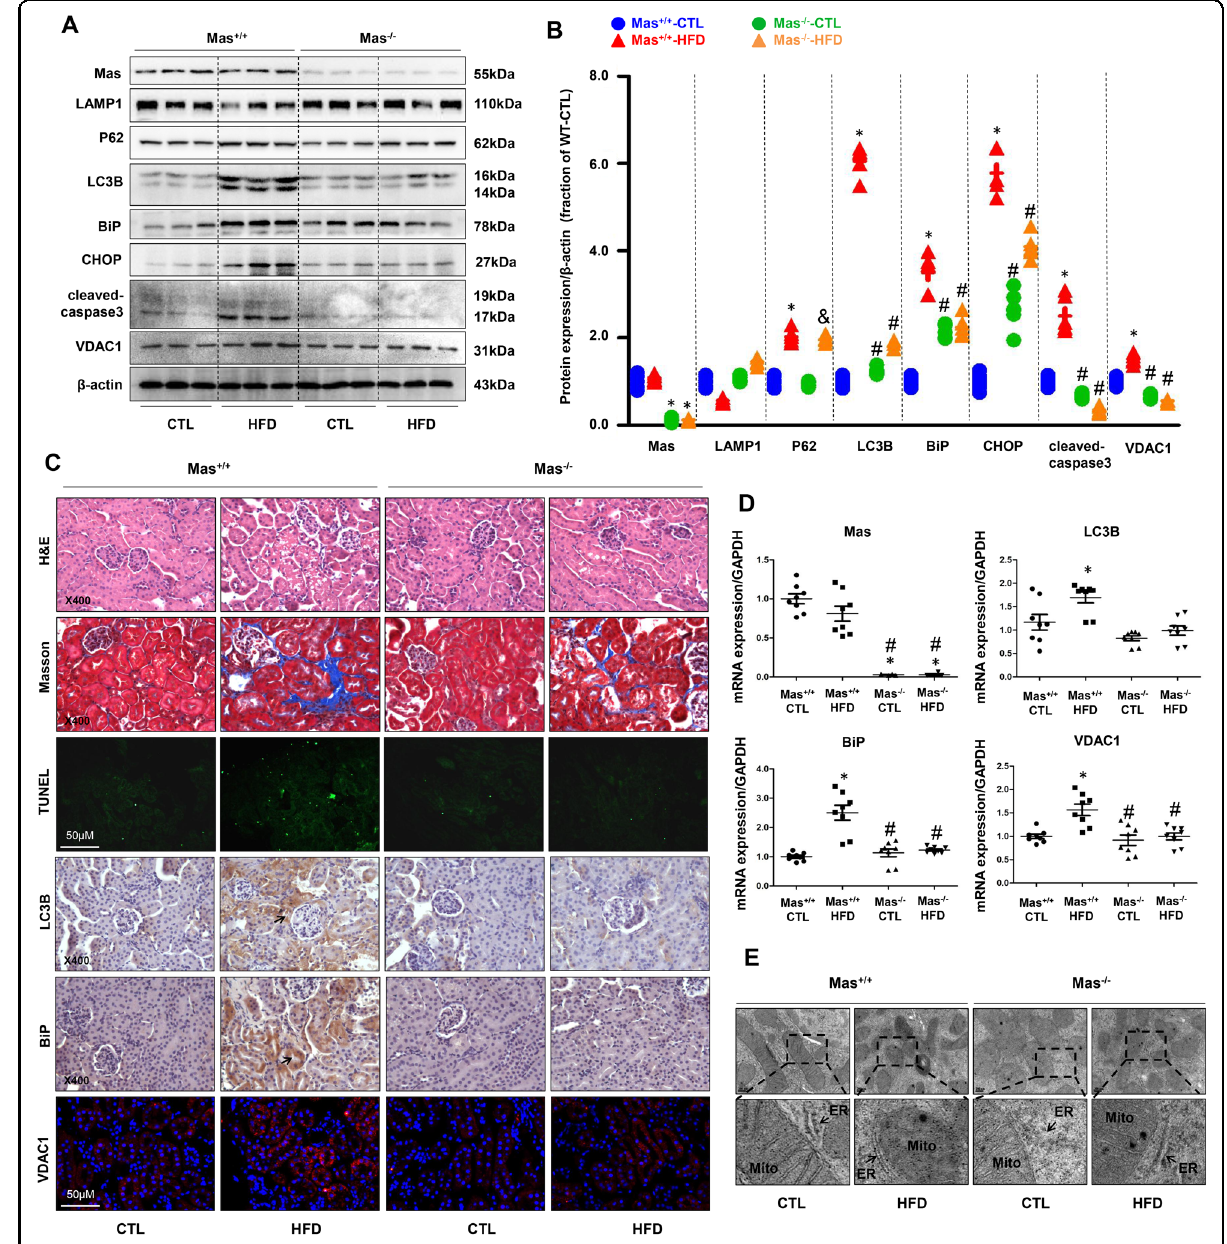
Fig. 1 Mas receptor deletion prevented high-fat diet-induced autophagy, ER stress, and apopotosis in the cortex of kidneys in mice. A and B Representative immunoblots and corresponding densitometry analysis of Mas, LAMP1, P62, LC3B, BiP, CHOP, cleaved-caspase-3 and VDAC1 protein abundance in the kidney cortex of Mas + / + CTL, Mas + / + HFD, Mas − / − CTL and Mas − / − HFD mice. C Representative photomicrographs of H&E, Masson staining and TUNEL staining in the kidney of Mas + / + CTL, Mas + / + HFD, Mas − / − CTL and Mas − / − HFD mice. Immunohistochemistry and immuno fl uorescence of LC3B, BiP, and VDAC1 in the kidney of Mas + / + CTL, Mas + / + HFD, Mas − / − CTL and Mas − / − HFD mice. D mRNA levels of VDAC1, LC3B and BiP in the kidney cortex of Mas + / + CTL, Mas + / + HFD, Mas − / − CTL and Mas − / − HFD mice. E Representative images of mitochondria and endoplasmic reticulum by transmission electron microscopy (TEM) in proximal tubular cells prepared from Mas + / + CTL, Mas + / + HFD, Mas − / − CTL and Mas − / − HFD mice. CTL controls, HFD high-fat diet. Data are shown as mean ± SEM; * P < 0.05 compared with Mas + / + CTL; # P < 0.05 compared with Mas + / +